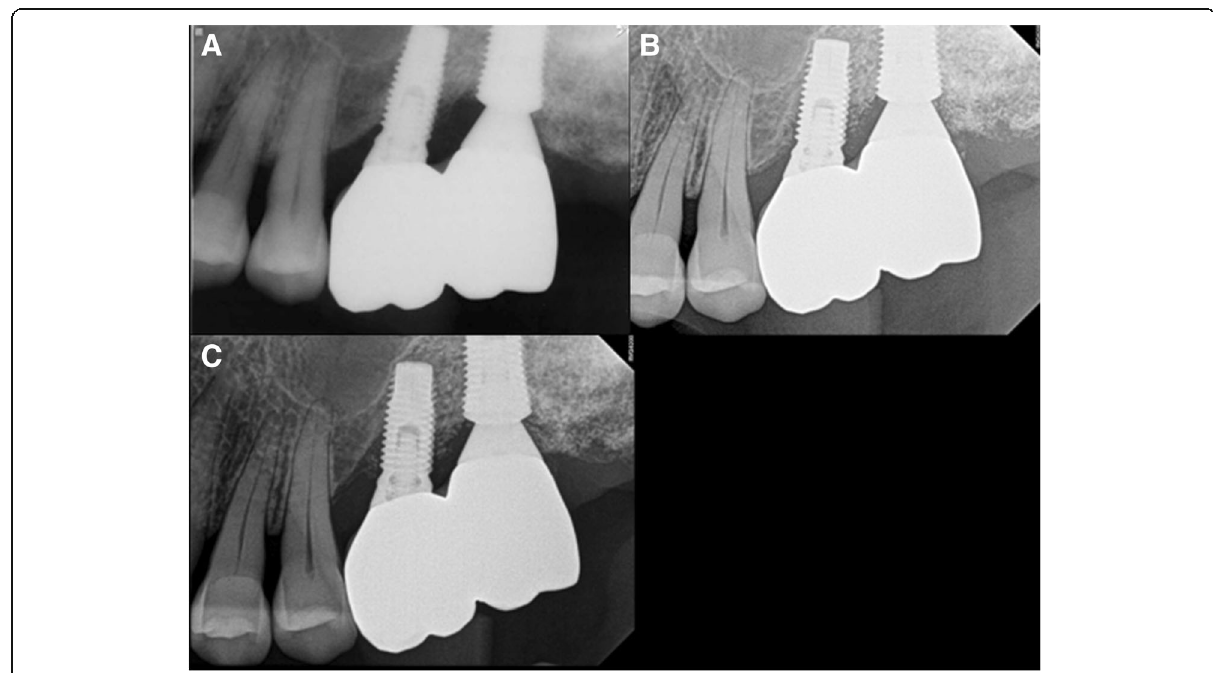
Fig. 8 F2, periapical radiograph, a #27i, prosthesis delivery, b #27i peri-implantitis, #26i increasing radiolucent lesion, c #27i peri-implantitis, #26i mesial bone loss